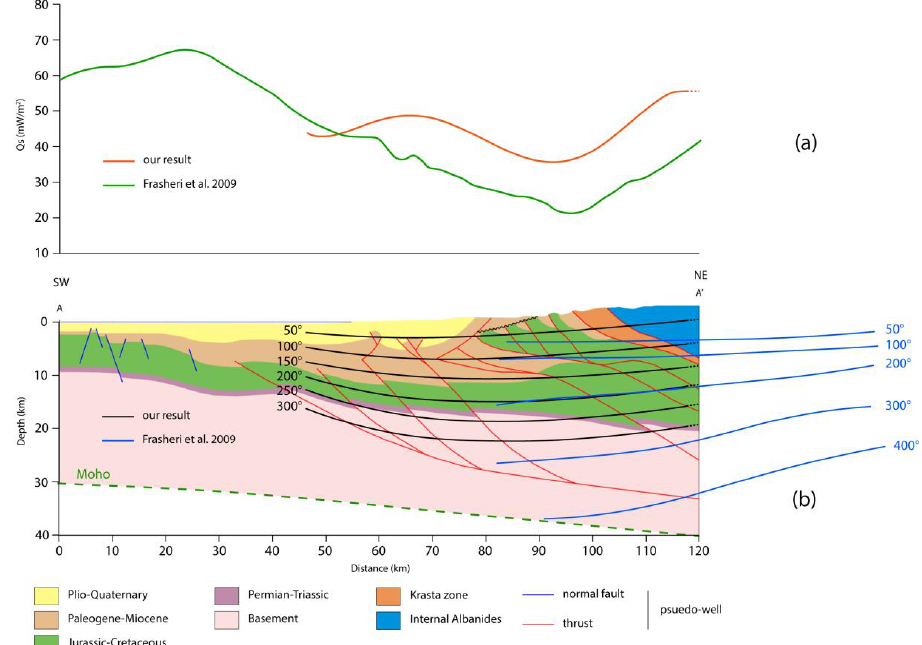
Figure 9. ( a ) Calculated surface heat flow ( Q s ) compared with the curve by Frasheri et al. [6]. ( b ) Thermal structure of the outer Albanides and adjacent Adriatic sector from this study, compared with isotherms by Frasheri et al. [6]. Energies 2020 , 13 , x FOR PEER REVIEW